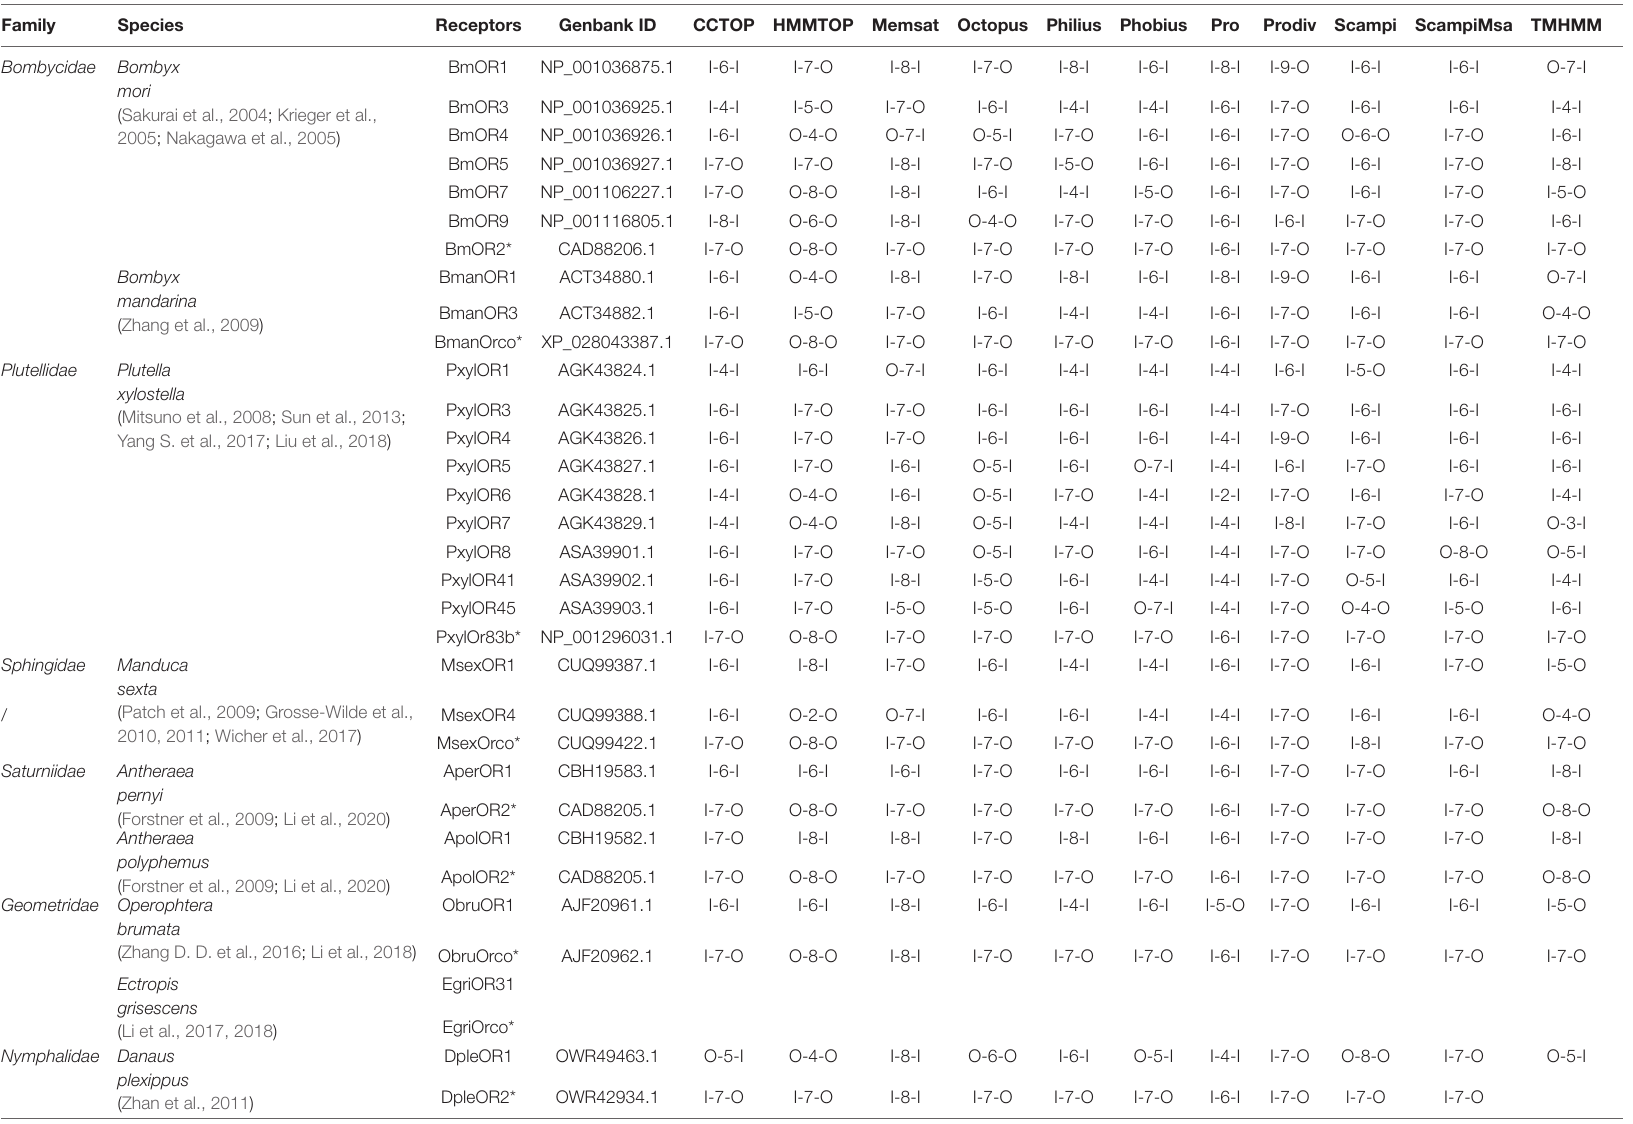
TABLE 1 | The CCTOP results of SPRs and Orcos from 10 families in Lepidopteran insects. Family